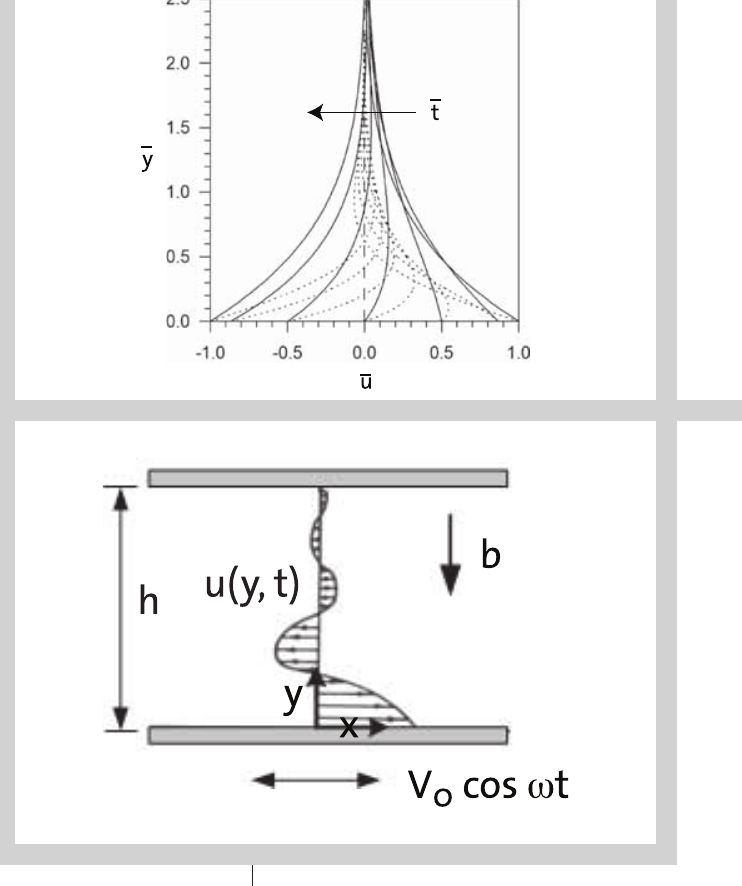
Figure 3 (above): Calculated velocity profiles at different time slices: (a) b = b = b = 0.1 and 1 4 4 b = 0.5 2 = b = 0.1 and (b) b 1 2 b = b = 0.25 4 5 (solid: present model, dotted: Newtonian fluid). Figure 4 (below): Sketch of an unsteady flow between to infinite parallel plates driven by the oscillat- ing motion of the lower plate and the coordinate